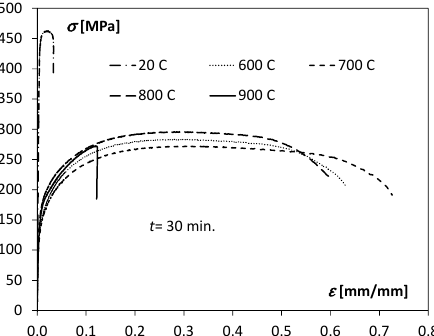
Figure 5. Exemplary of tensile curves for Ti/Cu bimetal samples unheated and annealed in the tem- perature range of 600–900 °C for t = 30 min.